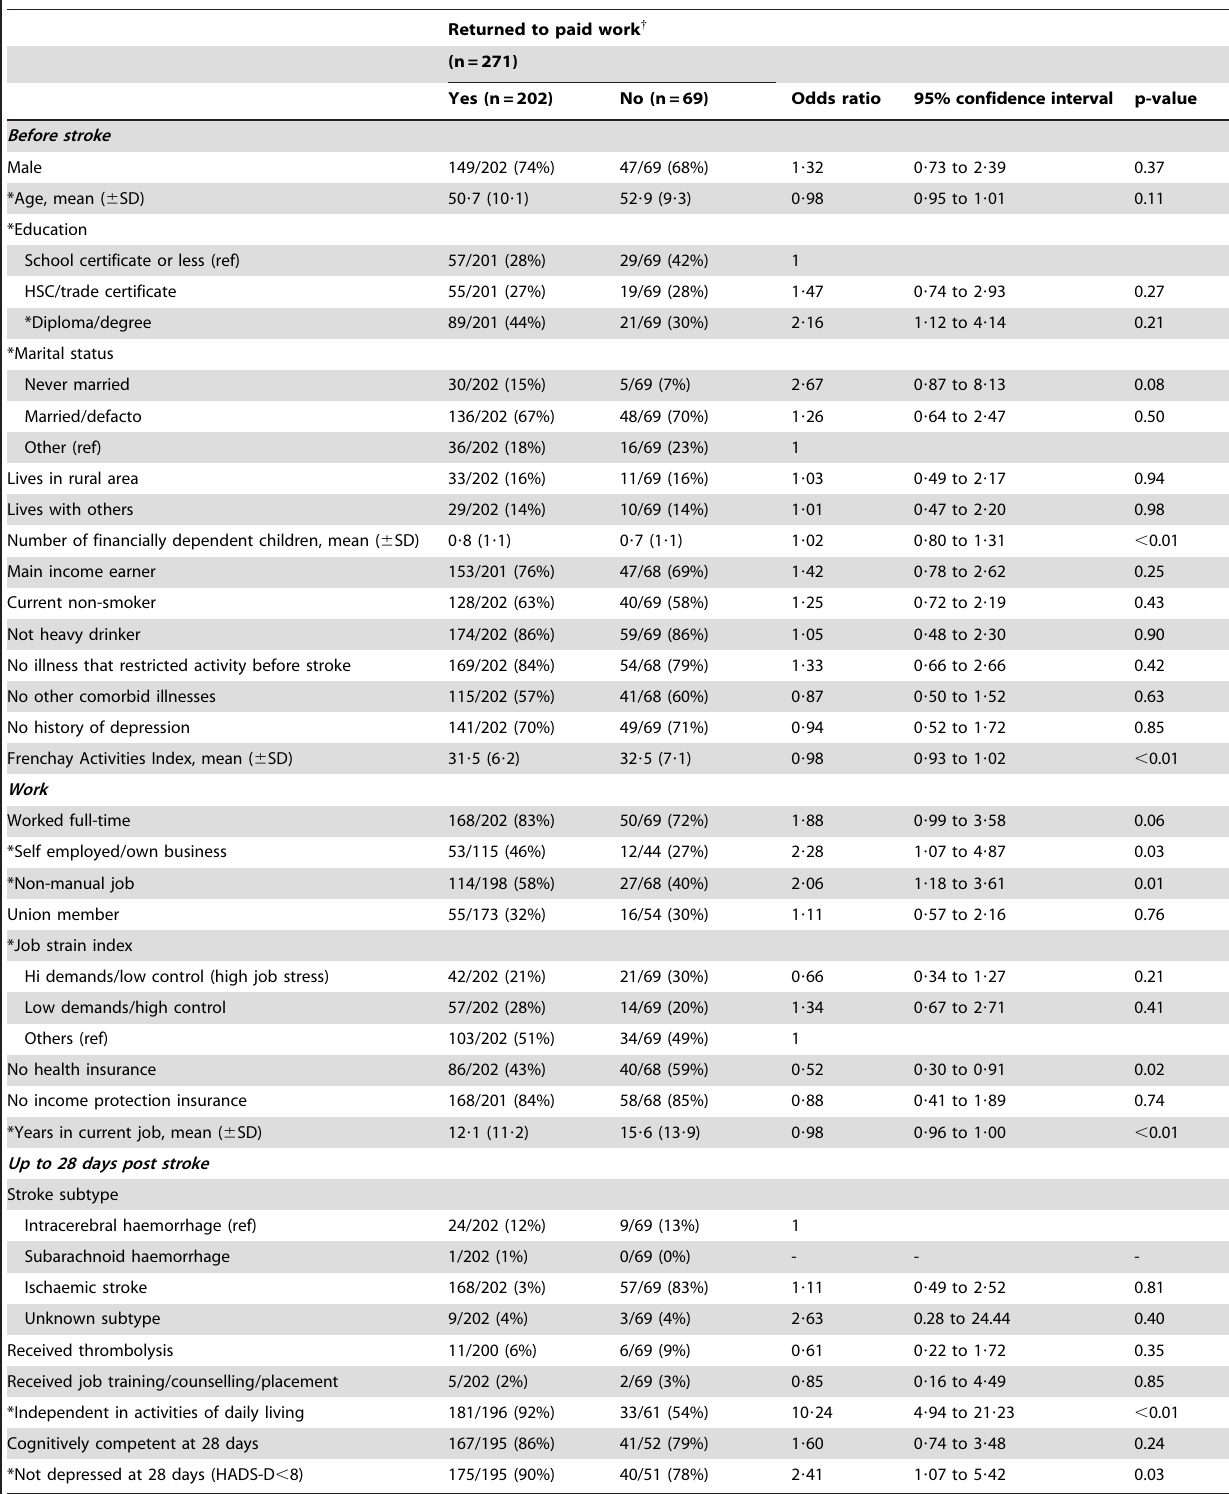
Returned to paid work